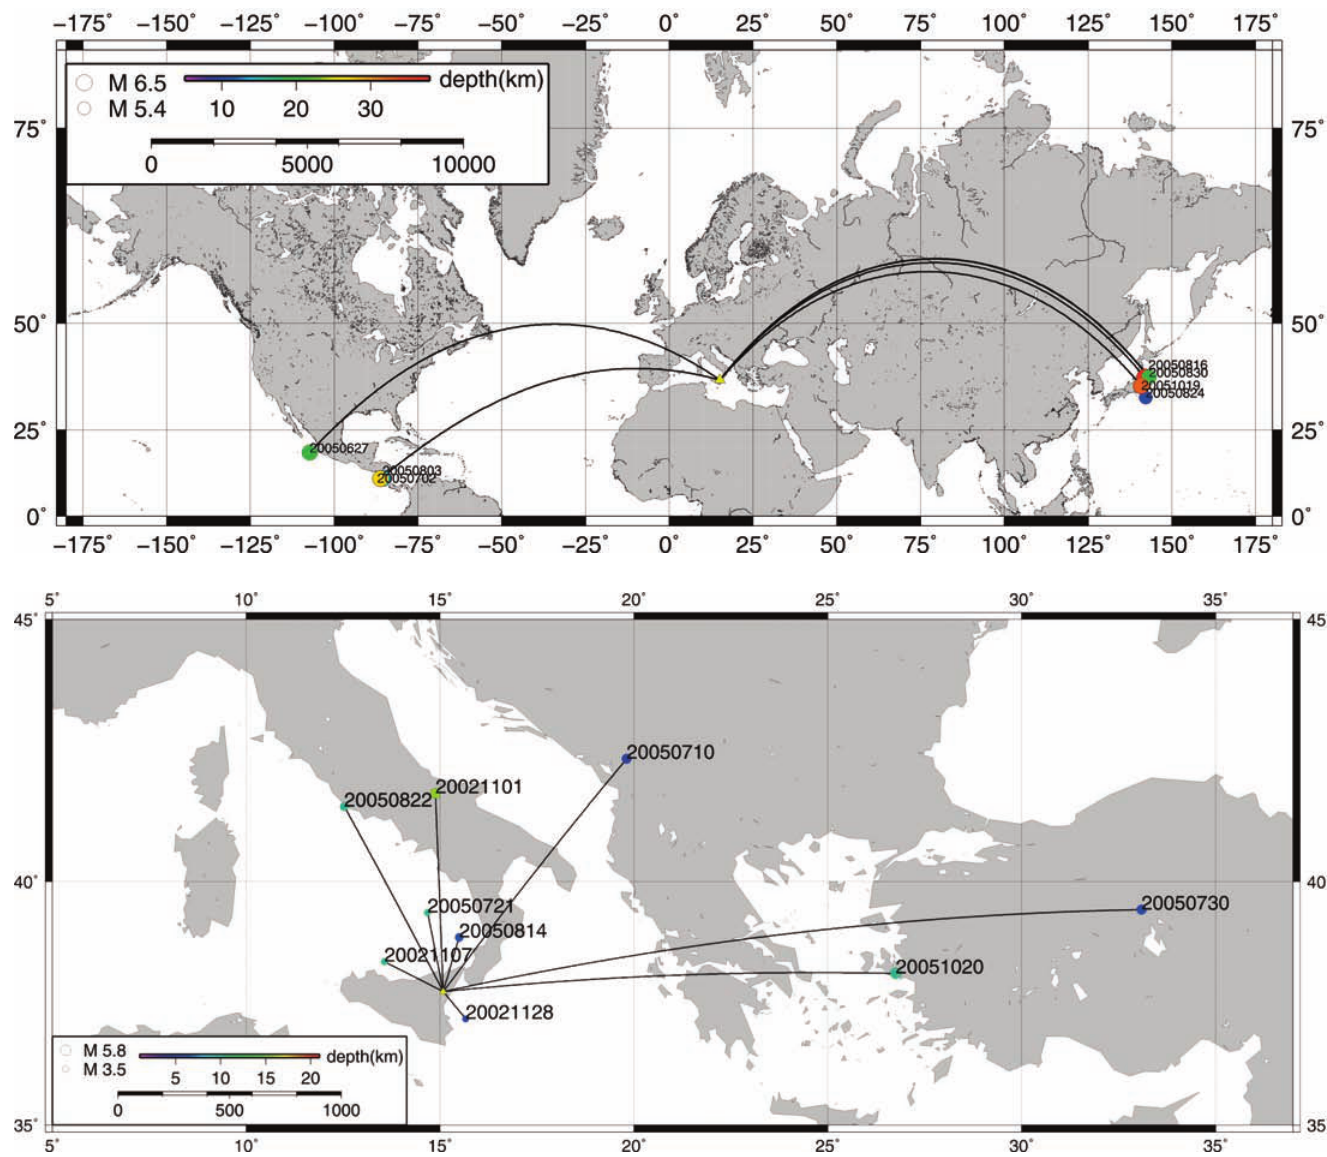
Figure 3 (top). Locations of the teleseisms used for the dispersion analysis. Figure 4 (bottom). Locations of regional and local earthquakes used for the dispersion